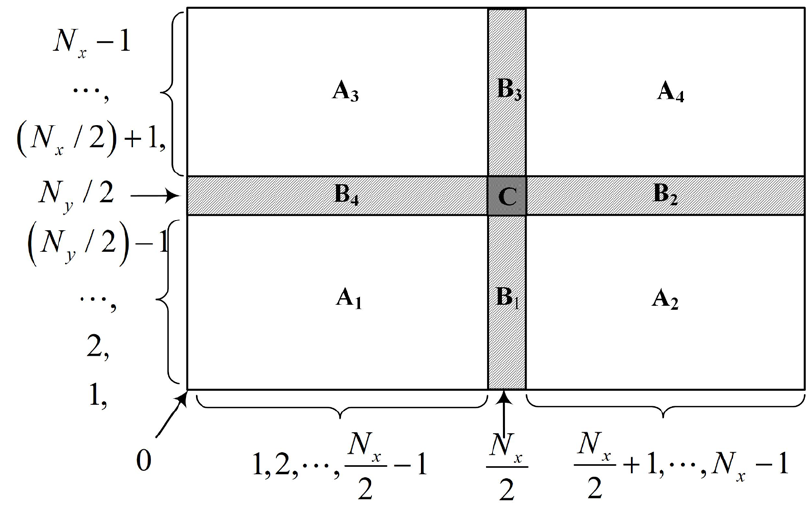
Figure 2. Regional division of the original angular spectrum.